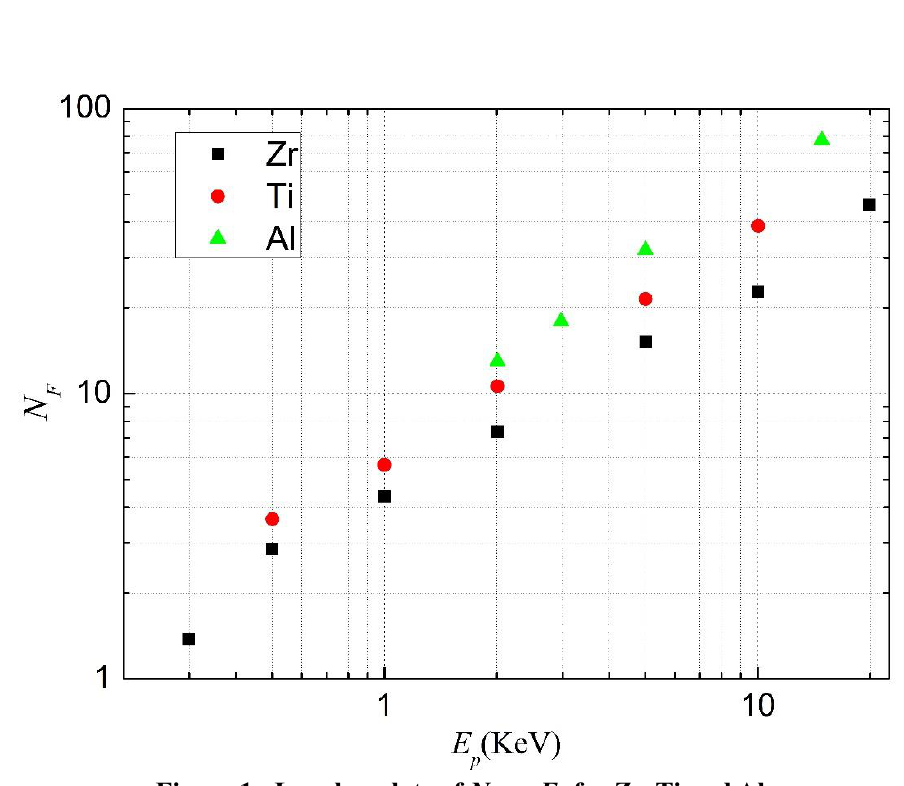
Figure 1. Log–log plots of N